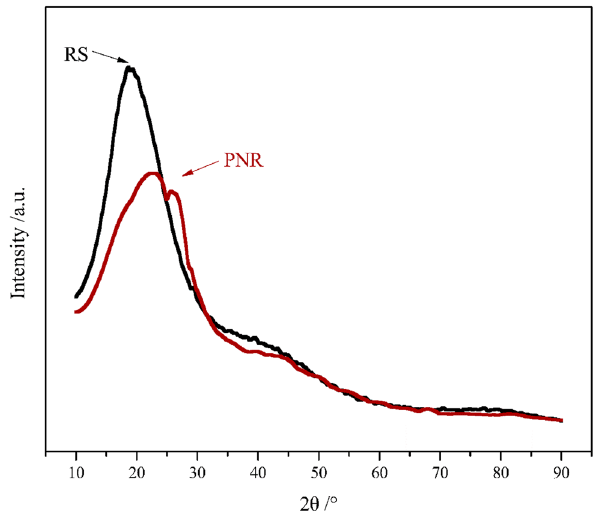
Figure 10: XRD patterns of cured PNR and